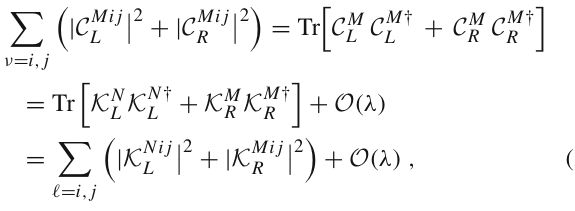
Table 1 Upper limits on charged dilepton couplings K sd (cid:4)(cid:4) (cid:2) p T [14,15] (top row), charged dilepton K -decays (mid) and derived ones from K decays to dineutrinos (bottom). Numbers correspond to